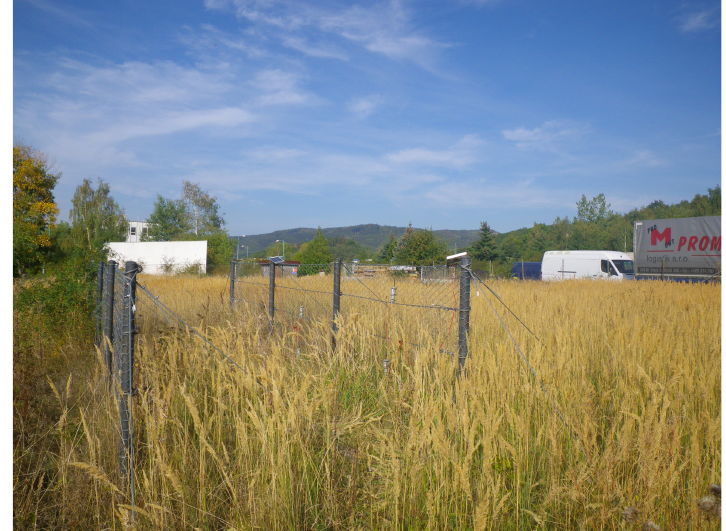
Figure 8. Physical model of the protective fence where the accelerometer wireless sensor nodes were